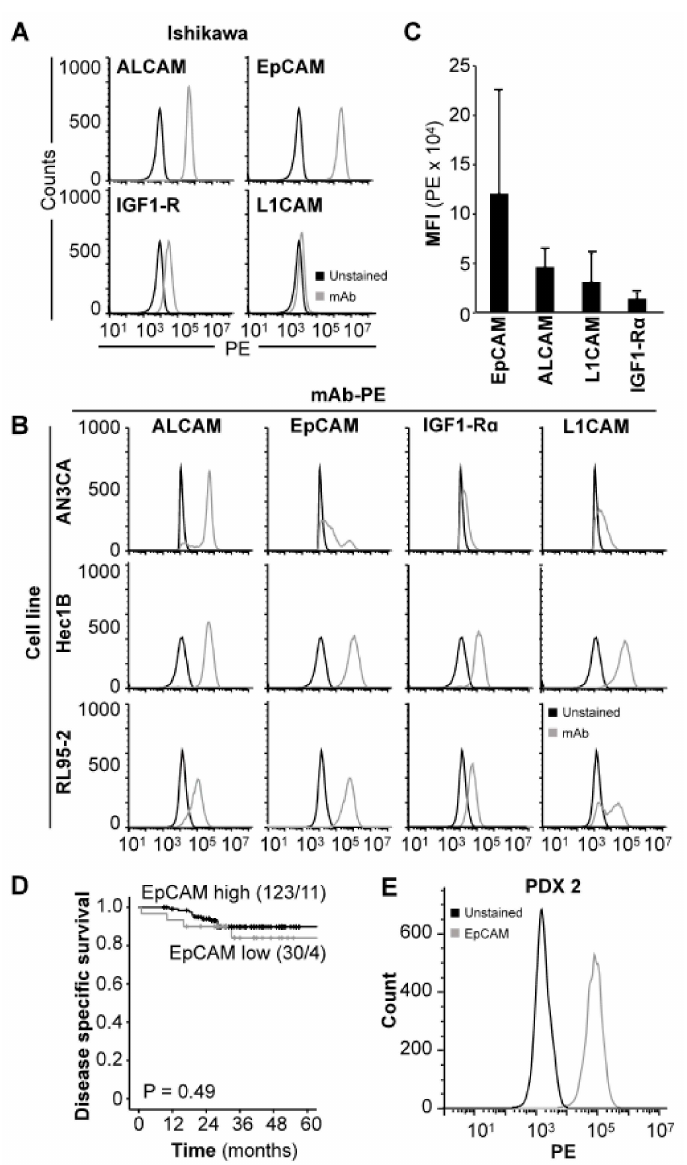
Figure 1. EpCAM is expressed in both endometrial carcinoma cell lines and tumors. Protein expression of ALCAM, EpCAM, IGF-1R α and L1CAM in Ishikawa ( A ) and AN3CA, Hec1B and RL95-2 ( B ) cell lines demonstrated by flow cytometry using PE-conjugated antibodies. MFI values of EpCAM, ALCAM, IGF-1R α and L1CAM in the explored cell lines combined ( C ). Kaplan Meier plot illustrating the lack of significant di ff erences in disease specific survival between patients with high or low EpCAM expression in primary tumor ( D ). In vitro protein expression of EpCAM in PDX-derived tumor cells (PDX 2) demonstrated by flow cytometry ( E ). Abbreviations: Activated leukocyte cell adhesion molecule (ALCAM), Epithelial cell adhesion molecule (EpCAM), Insulin-like growth factor 1 receptor alpha (IGF1R α ), L1 cell adhesion molecule (L1CAM), Monoclonal antibody (mAb), Patient-derived xenograft (PDX), and Phycoerythrin